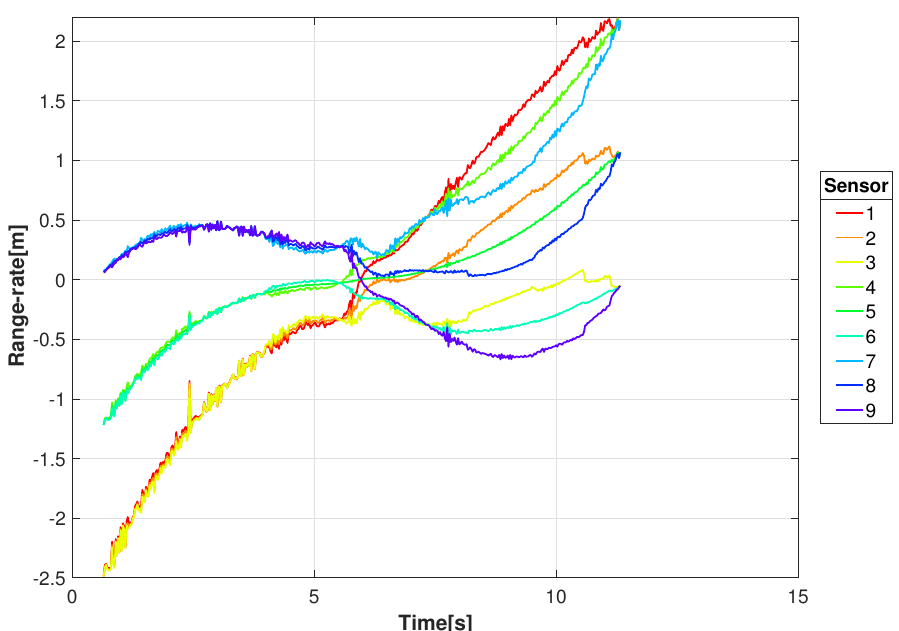
Figure 9. Example range-rate between a transmitting target (GT #1) and the locations of the RF sensor constellation.